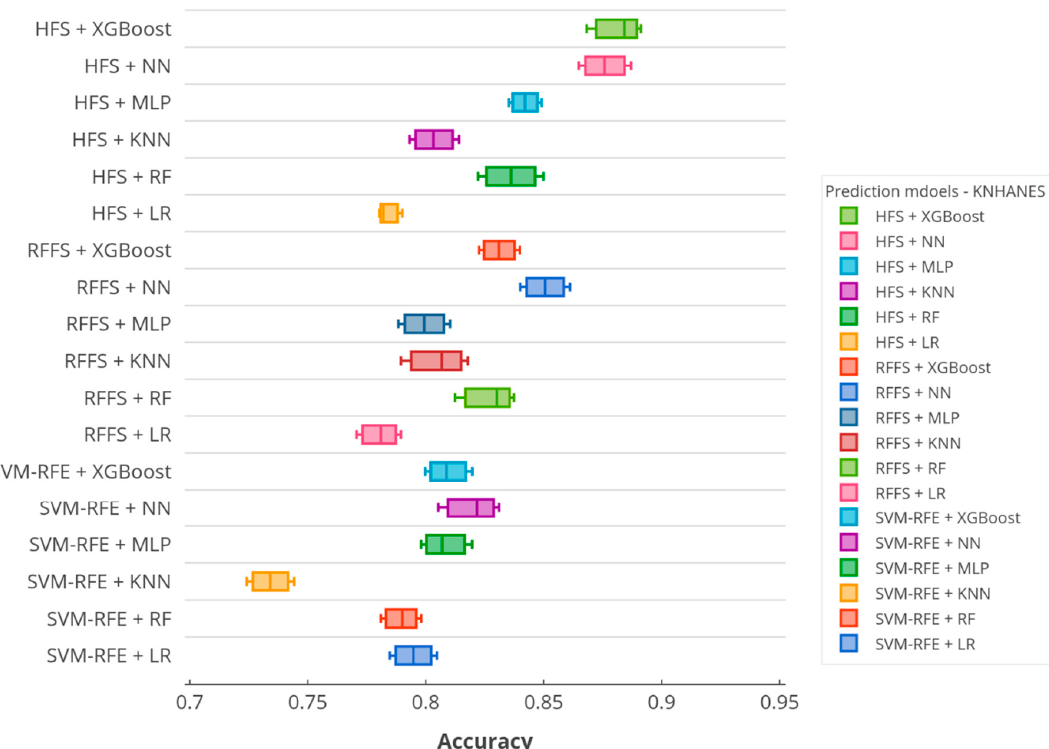
Figure 5. Boxplot of the accuracy over prediction models in the KNHANES dataset.